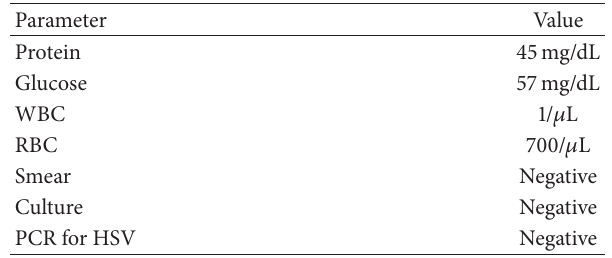
Table 1: Results of the routine laboratory tests. Table 2: Results of the lumbar